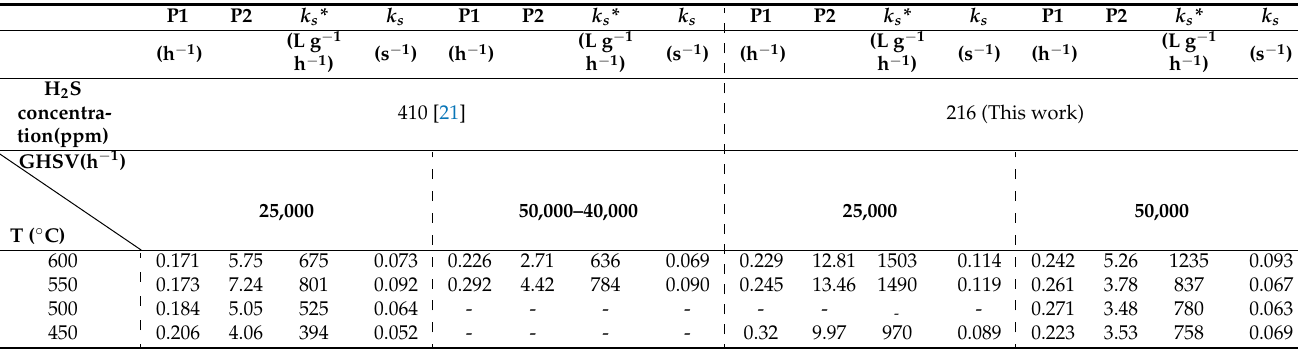
Table 9. Kinetic parameters from the fitting of the deactivation model (P1 ( k d ), P2, v s , and k s * ) for experimental results obtained in this investigation and found in